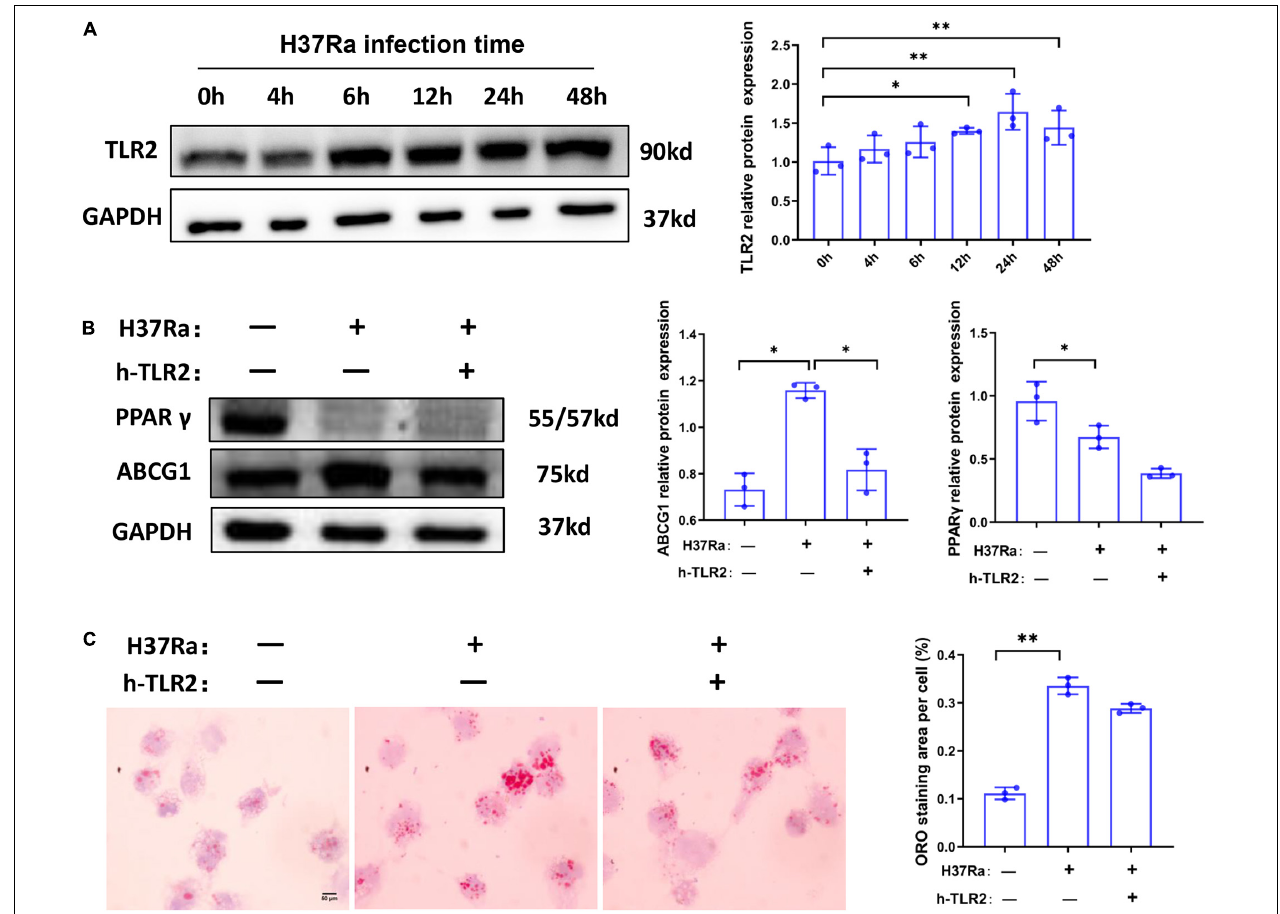
FIGURE 4 | The expression change of peroxisome proliferator activated receptor γ (PPAR γ ) in macrophages in the course of Mycobacterium tuberculosis ( Mtb ) infection is TLR2-independent. THP-1 cells were infected with H37Ra for the indicated times and then harvested for the detection of TLR2 expression by western blot (A) . THP-1 cells were pretreated with h-TLR2 (5 µ g/ml) for 1 h, followed by infection with H37Ra (MOI = 10:1), and the protein expression levels of PPAR γ and ABCG1 were determined by western blot (B) , the intracellular lipid accumulation were evaluated by ORO staining [ (C) , 1,000 × ]. Scale bar = 50 µ m. Data are expressed as the means ± SD of at least three independent experiments, ∗ P < 0.05, ∗∗ P <